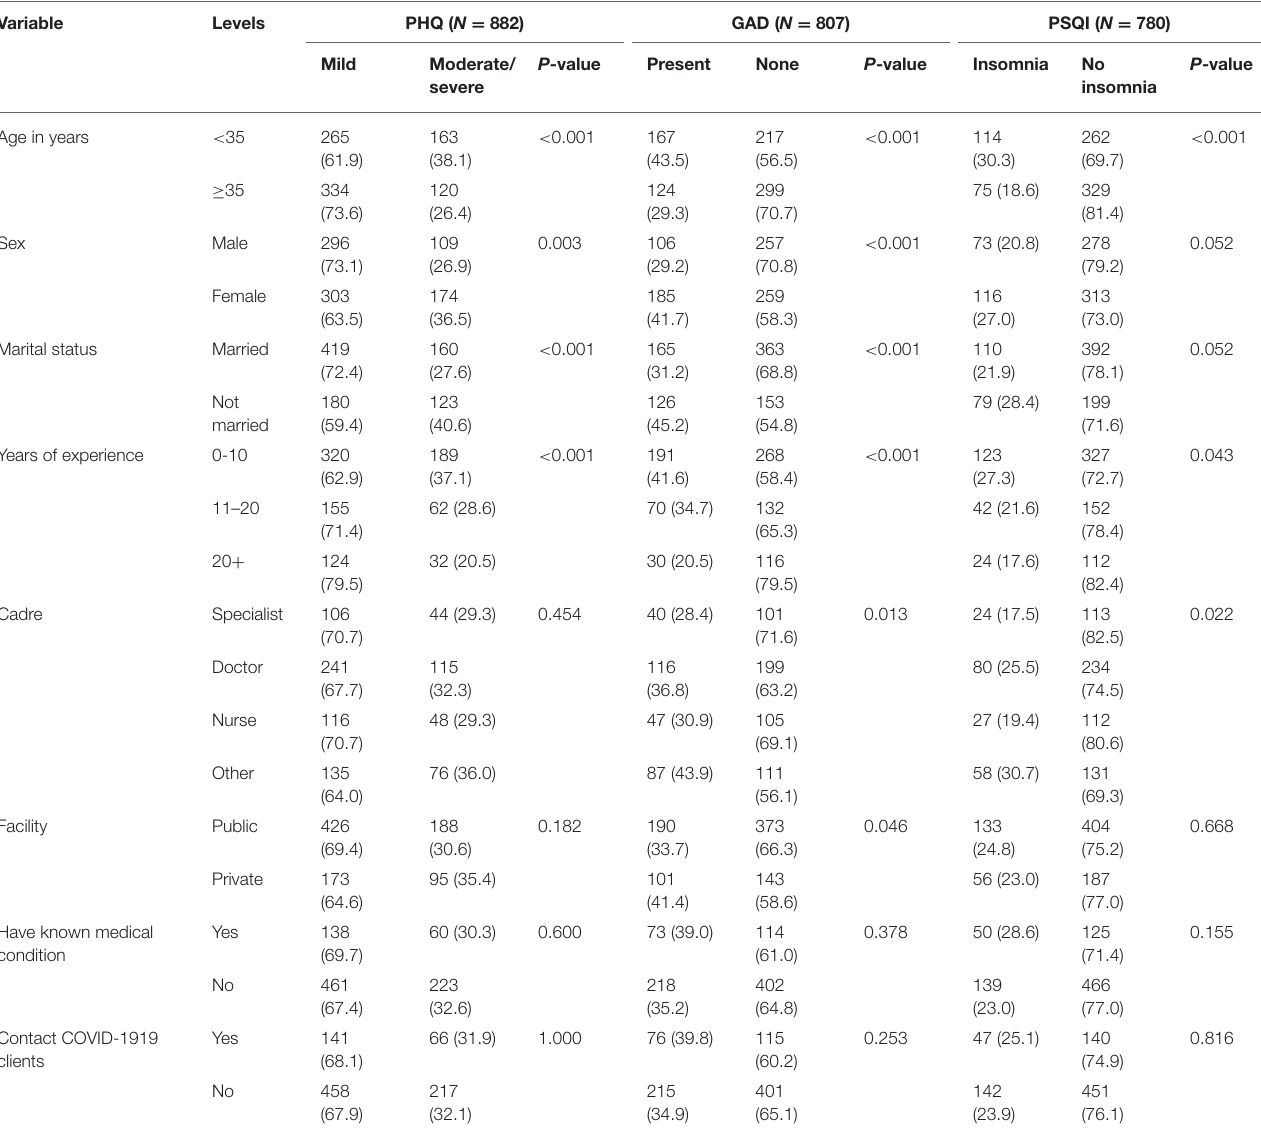
TABLE 3 | Factors associated with mental disorders on bivariate analysis.